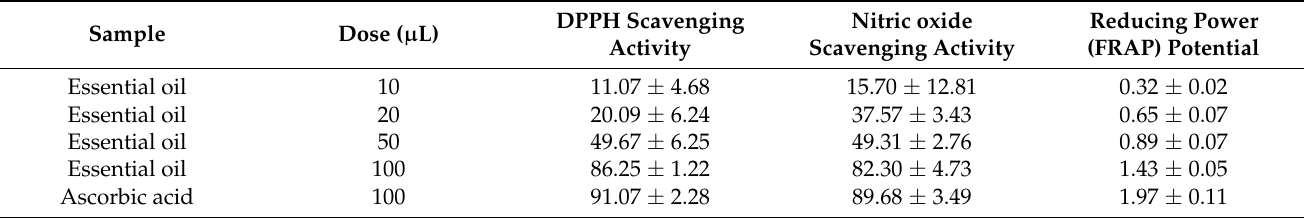
Table 3. The antioxidant half-maximal inhibitory concentration IC 50 inhibition values for the oil.